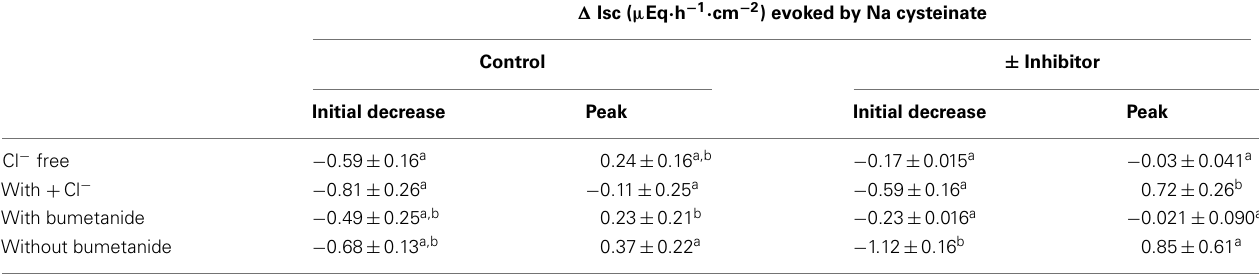
Table 3 | Effect of Na cysteinate after inhibition of Cl − secretion.